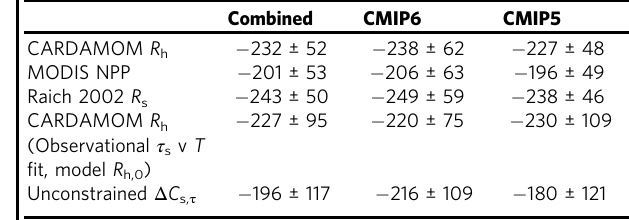
The table presents the sensitivity of the emergent constraint on Δ C s, τ to model ensemble: CMIP5, CMIP6 or CMIP5 and CMIP6 combined (columns), and to the observational dataset for heterotrophic respiration (rows). The penultimate row presents the constraint using the observational τ s v T fi t and model R h,0 , opposed to observational R h,0 , to isolate the uncertainty reduction from these different components. For comparison, the last row shows the mean and standard deviation of the unconstrained model